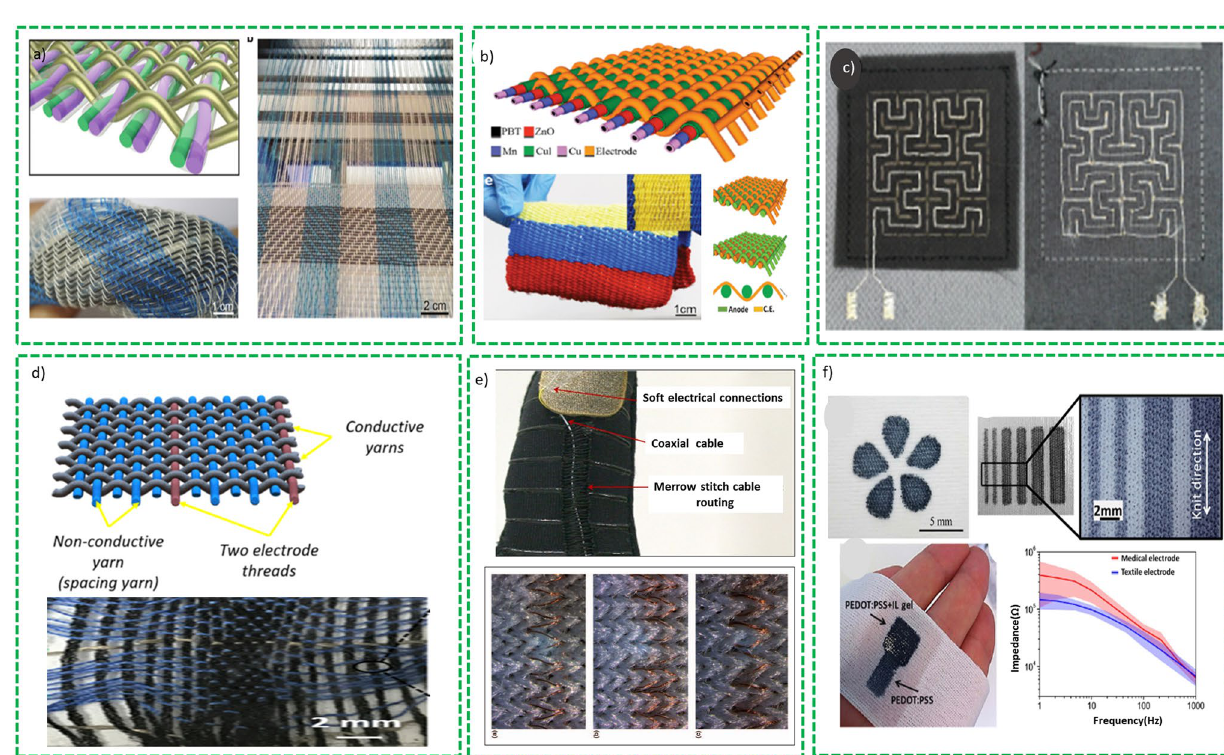
Fig. 20 a Graphical representation of fiber-shaped lithium-ion battery. Reprinted with permission from Ref. [219]. b Schematic of photovoltaic textile and a pictorial of an as developed photovoltaic textile mixed with colored wool wires with anode and cathode. Reprinted with permission from Ref. [220]. c Pattern of conductive inks, reprinted with permission from Ref. [221]. d – f Conductive circuit on textile embedded in/on tex- tile by different textile techniques, d reprinted with permission from Ref. [222]. e Knitting, reprinted with permission from Ref. [223]. f Embroi- dery, flower pattern conductive polymers on textile substrate. Reprinted with permission from Ref.